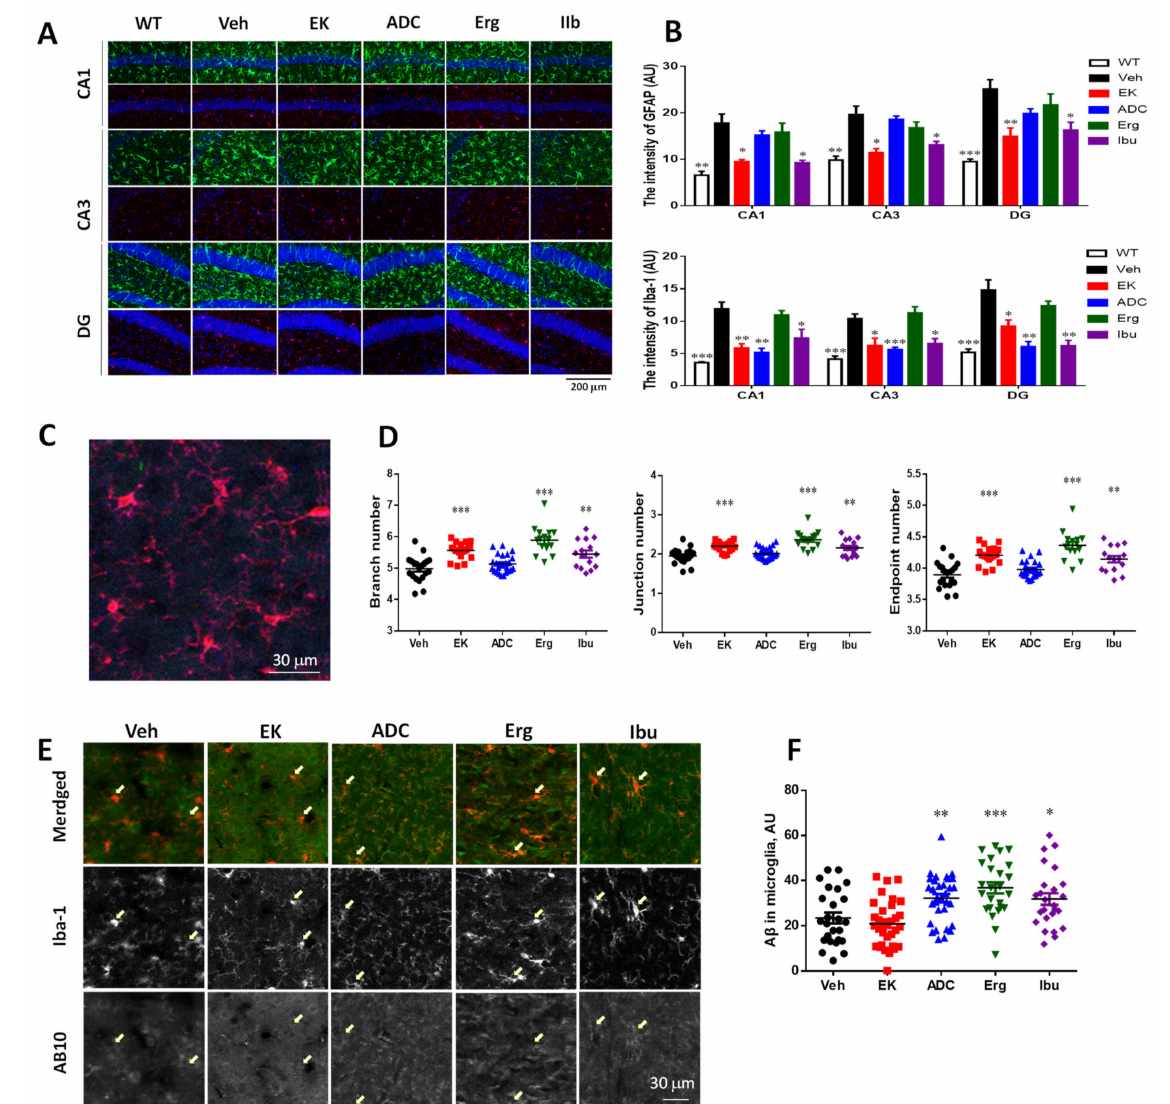
Figure 5. EK100 reduce non-clustered glial activation in APP/PS1 mice. APP/PS1 transgenic mice orally administered vehicle (Veh) or EK100 (EK), antrodin C (ADC), ergosterol (Erg), and ibuprofen (Ibu) (30 mg · kg − 1 · day − 1 , each n = 6) for 1 month, and then astrocytes and microglia were immunostained with GFAP and Iba-1 antibodies, respectively. ( A , B ) The representative immunostaining images of GFAP (green) and Iba-1 (red) without being associated with plaque in Cornu Amonis (CA)1, CA3, dentate gurus (DG) are shown in ( A ). The image in wild-type (WT) mice ( n = 6) is also compared. Scale bar: 200 µ m. The level of GFAP and Iba-1 in the CA1, CA3, and DG are calculated by MetaMorph image analysis software and shown in ( B ). The results are the mean ± S.E.M. Significant differences between the Veh group and the other groups are indicated by *, p < 0.05; **, p < 0.01; ***, p < 0.001. ( C , D ). The representative image of Iba-1 (red) not associated with plaque is shown in ( C ). The branch number, junction number, and end point number of Iba-1 immunostained microglia are calculated by FIJI ImageJ software. The results are the mean ± S.E.M. Significant differences between the Veh group and the other groups are indicated by **, p < 0.01; ***, p < 0.001. ( E , F ). The representative immunostaining images of Iba-1 (red) and A β not associated with plaque in the cortex are shown in ( E ). Arrows indicate the representative microglia. The intracellular A β in microglia are calculated by MetaMorph image analysis software and shown in ( F ). The results are the mean ± S.E.M. Significant differences between the Veh group and the other groups are indicated by *, p < 0.05; **, p < 0.01; ***, p <